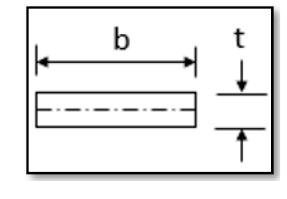
Figure 3. Cross section of spring.